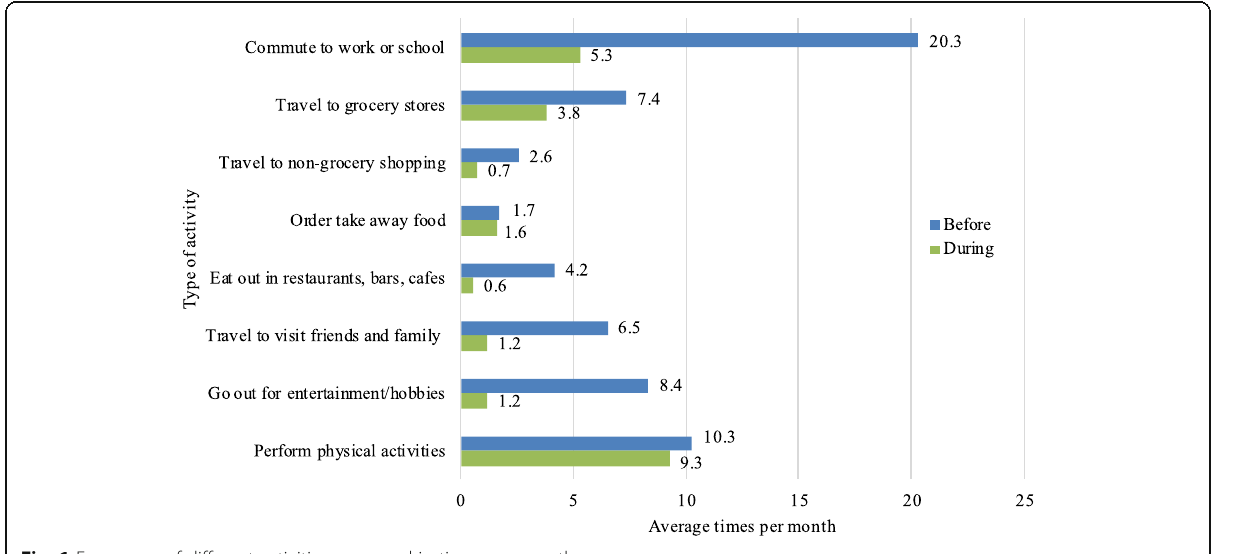
Fig. 1 Frequency of different activities measured in times per